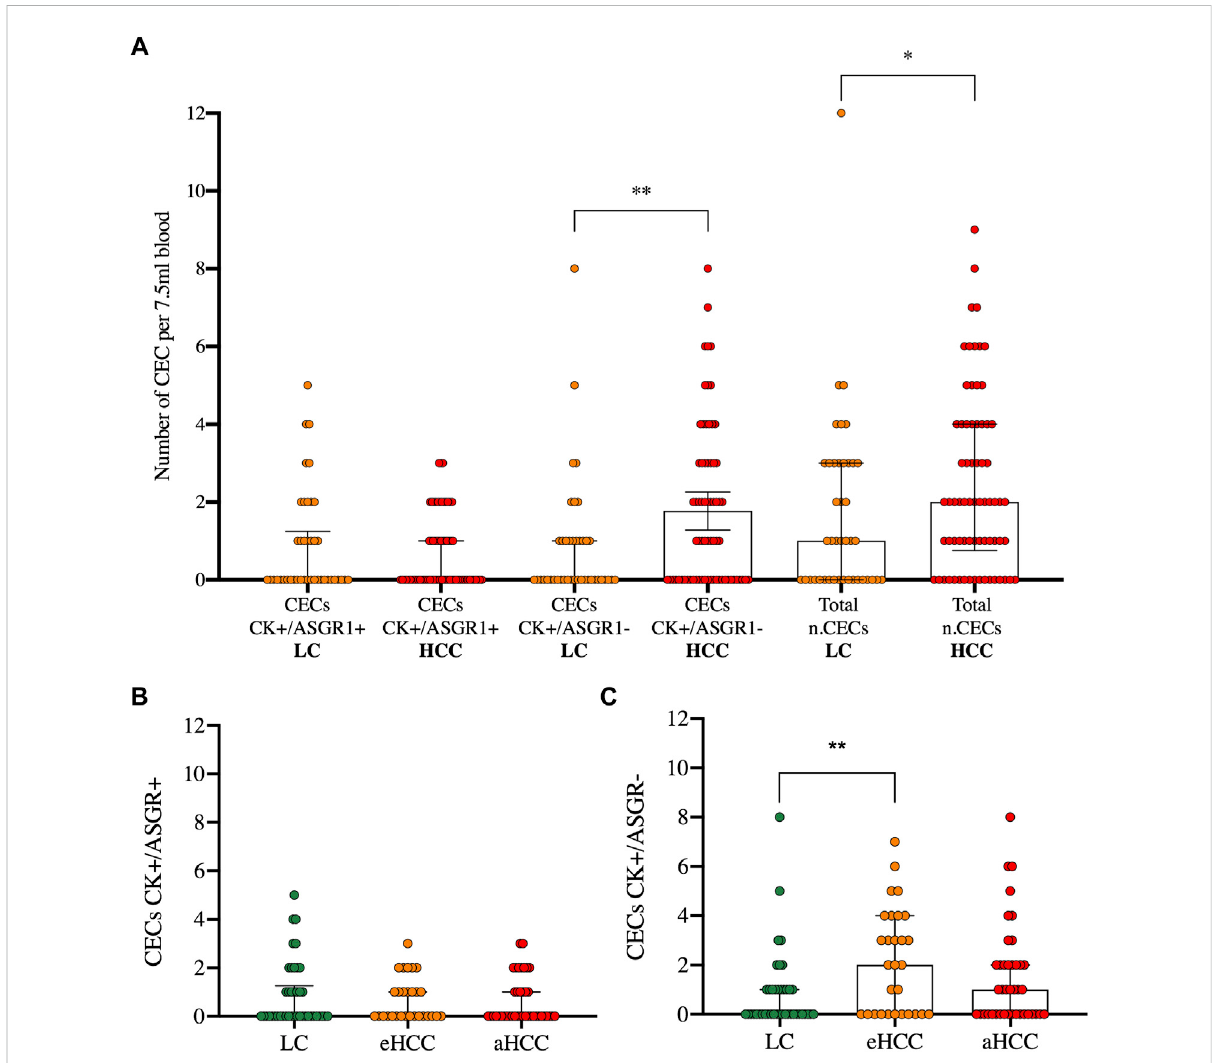
FIGURE 3 CECs enumeration in blood in patients with liver cirrhosis or HCC. CECs are characterized by either double staining (CK+/ASGR1+) or single staining (CK+/ASGR1-) in liver cirrhosis (LC) and hepatocellular carcinoma (HCC) patients (A) . The latter are divided into early (eHCC) and advanced (aHCC) disease for both, double (B) and single staining (C) . p values for Kruskal Wallis test and multiple comparisons are:** p = 0.0096 and * p = 0.035 (A) and ** p = 0.0051 (C)